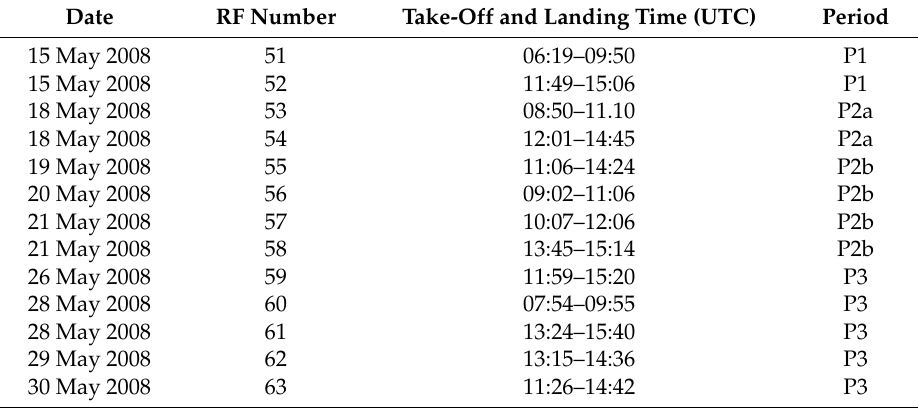
Table 2. ATR-42 flights during the IMPACT-EUCAARI campaign from 15 to 31 May 2008. In the Table are reported the date of the research flight (RF), flight number, takeoff and landing time, and period attributed to the flight. Refer to the main text (Section 4.4) for a detailed description of the